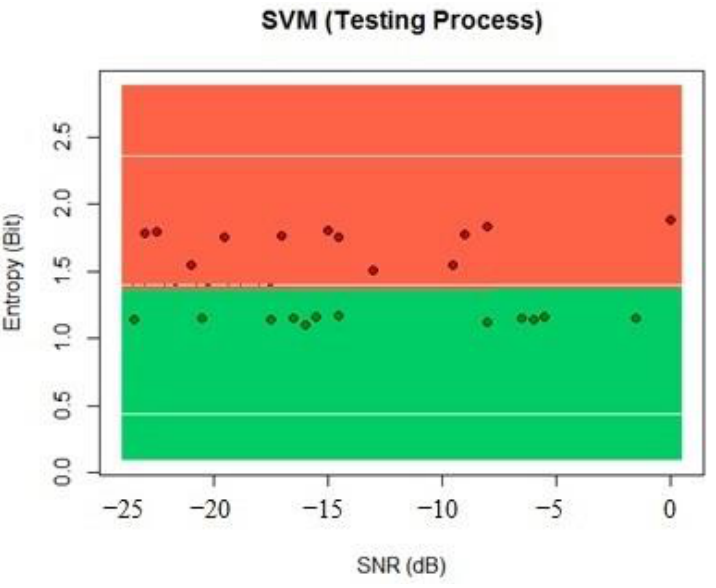
Figure 12. SVM testing process classification.